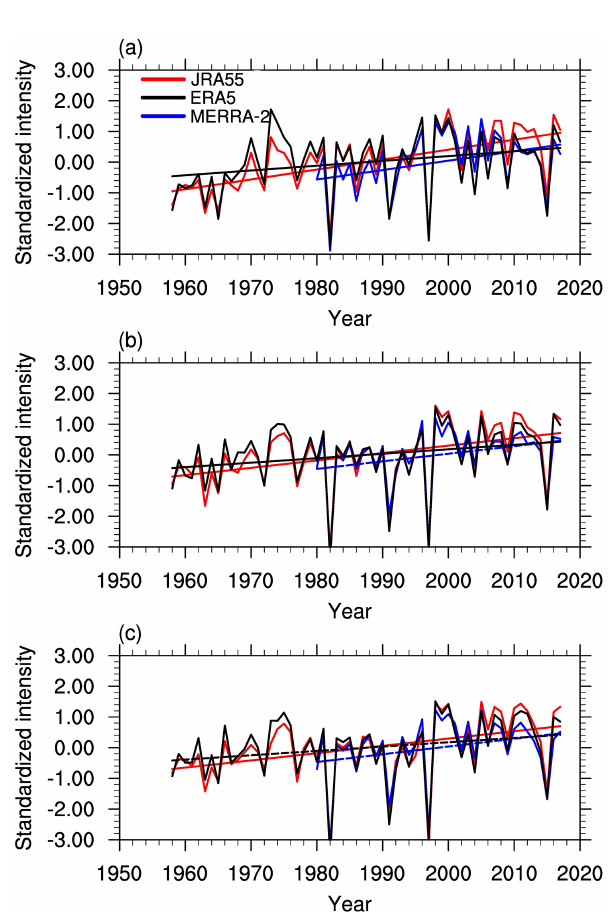
Figure 3. The time series of the standardized intensity of the up- ward motion over the tropical western Pacific (20 ◦ S–10 ◦ N, 100– 180 ◦ E) at (a) 150hPa, (b) 500hPa, and (c) 700hPa extracted from JRA55 (red), ERA5 (black), and MERRA-2 (blue) datasets. The straight lines in each figure indicate the linear trends. The solid lines denote the linear trends that are significant at the 95% confidence level, while the dashed lines denote the linear trends that are signif- icant at the 90% confidence